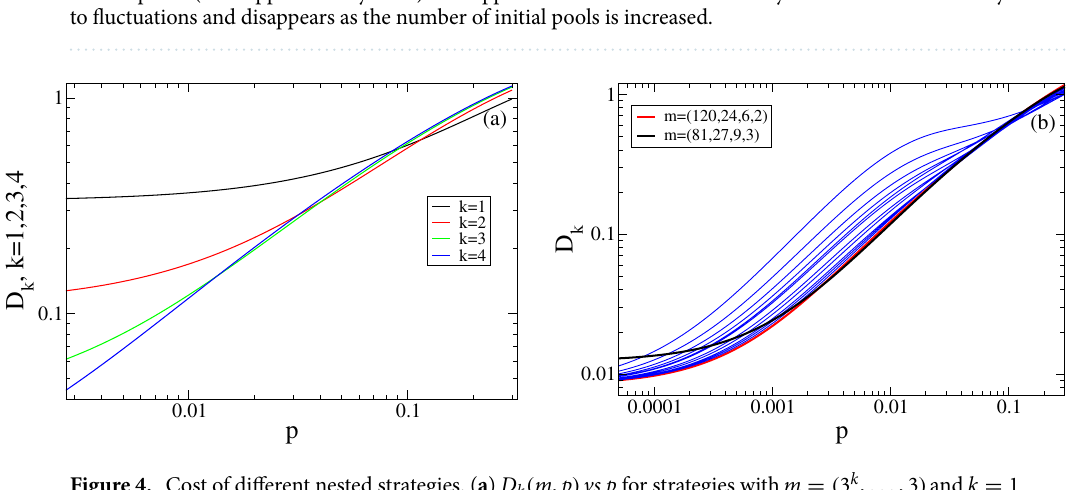
Figure 4. Cost of different nested strategies. ( a ) D k ( m , p ) vs p for strategies with m 2 (red), k 3 (green), k (black), k = = ( 120, 15, 3 ) , m ( 120, 12, 3 ) , m m = = ( 120, 4 ) , m ( 120, 3 ) and (120, 2) (blue), m m = =